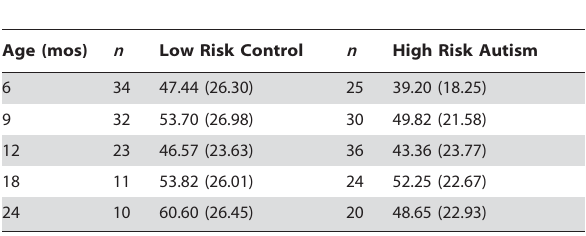
Table 2. Amount of data contributed by each group at each